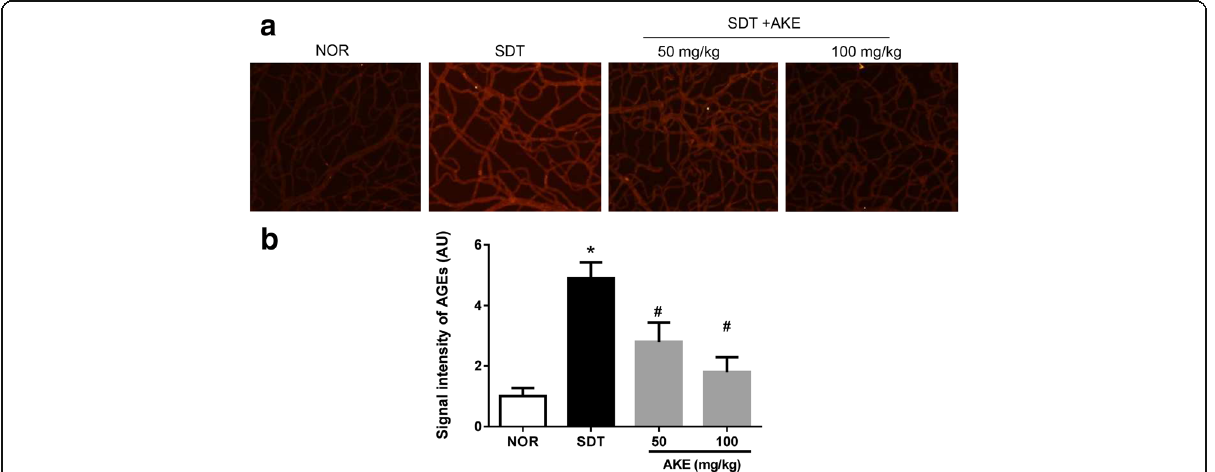
Fig. 4 Retinal AGEs accumulations. a Immunofluorescence staining for AGEs in trypsin-digested retinal vessels. b Quantitative analysis of the AGEs immunoreactive intensities. Values in the bar graphs represent the mean ± SE, n = 5. * p < 0.05 vs. NOR, # P < 0.05 vs.